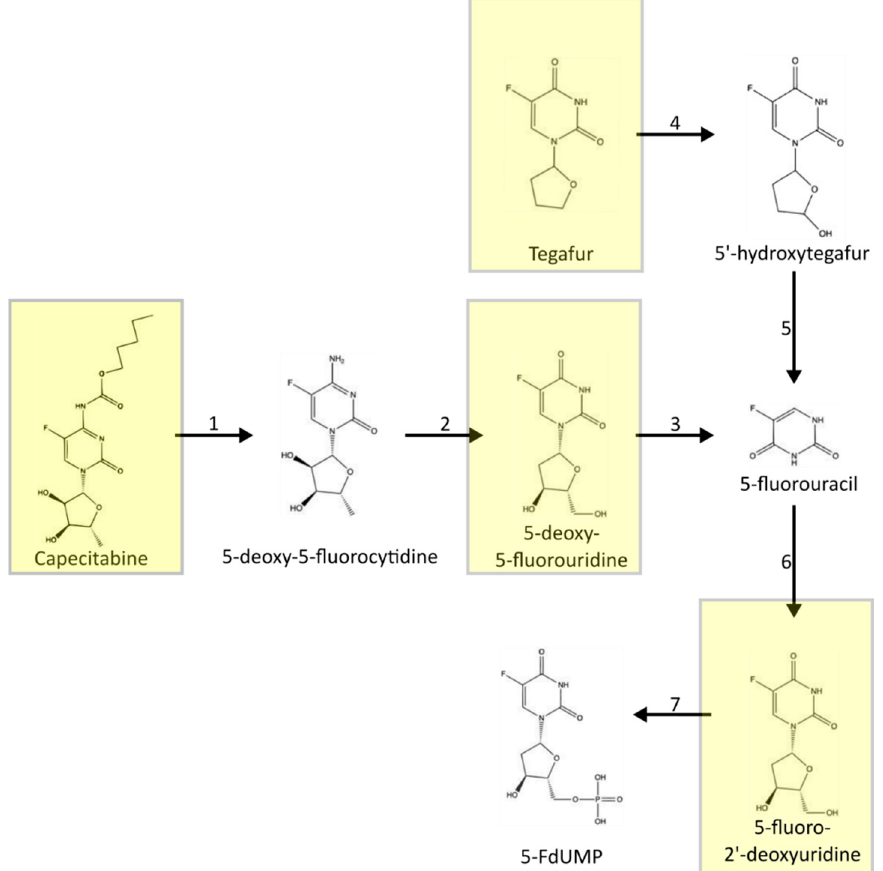
Figure 2. Metabolism of the prodrugs of 5-fluorouracil: capecitabine, 5-deoxy-5-fluorouridine, 5-fluoro-2 ′ -deoxyuridine, and tegafur. 1—carboxylesterase; 2—cytidine deaminase; 3—thymidine phosphorylase; 4—cytochrome P450 enzymes; 5—spontaneous degradation; 6—thymidine phosphorylase; 7—thymidine kinase. dehydrogenase; 14-dihydropyrimidase; 15- β -ureidopropionase; 16- aconitase inhibition. Based on: Muhale et al. and Shirasaka et al. with modification.